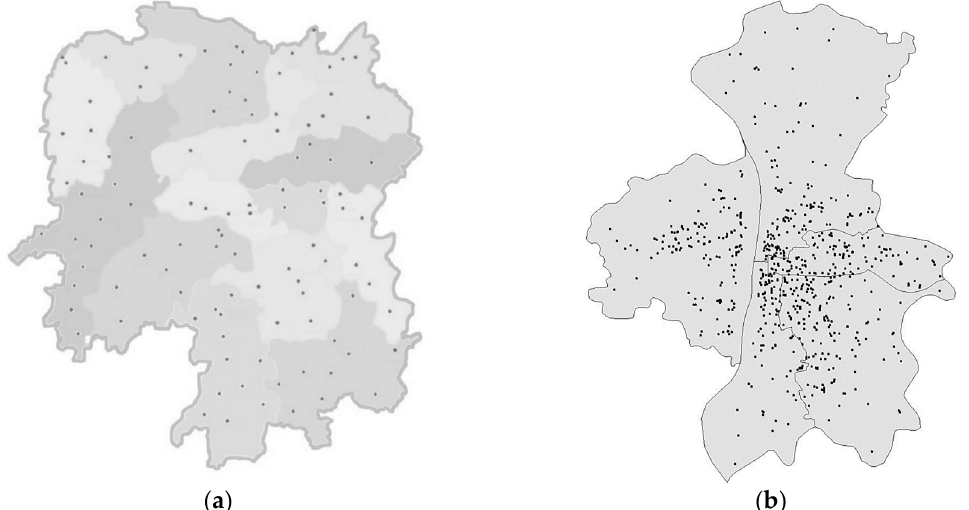
Figure 1. Node distribution for the two practical cases. ( a ) Ninety-five cities in Hunan Province and ( b ) 668 demand points in Changsha